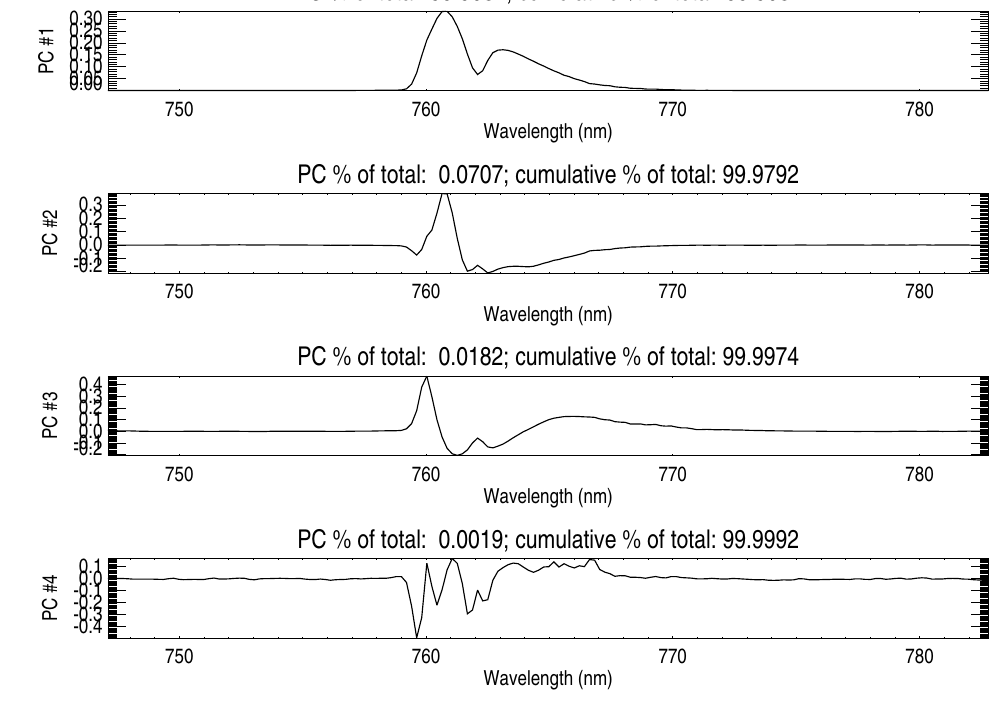
Fig. 8. Similar to Fig. 6 but for the long- wavelength fitting window computed using actual GOME-2 data.